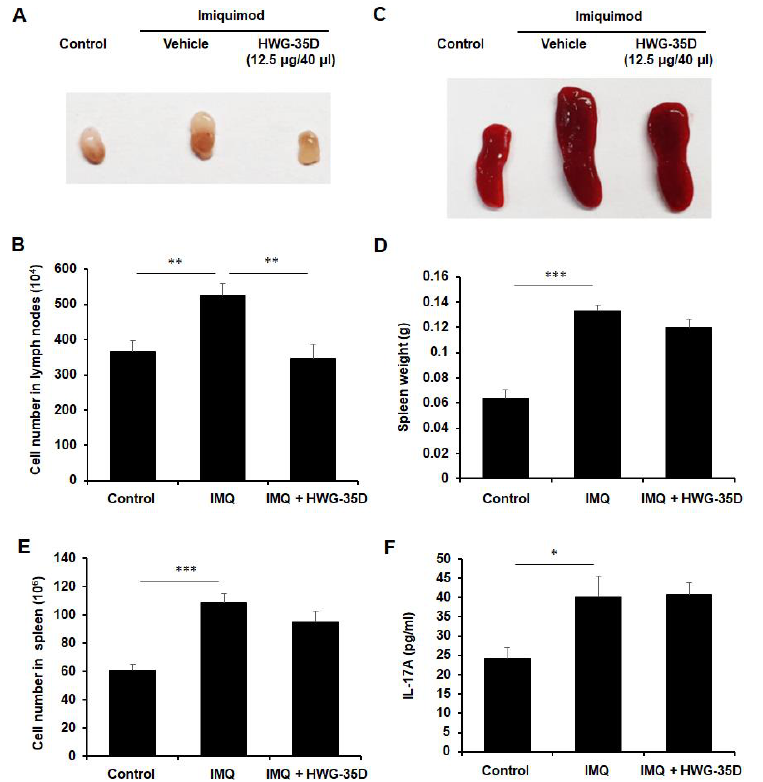
Figure 6. Topical application of HWG-35D with a dosage of 12.5 µg/40 µL surfactant only partially normalizes systemic immune response. ( A ) Gross morphologic examination of inguinal lymph nodes, and ( B ) their total cell numbers were counted in each group. ( C ) Gross morphologic features, ( D ) weights, and ( E ) total cell numbers of spleen were examined. ( F ) Serum IL-17A levels were examined using ELISA. Data are mean ± S.E.M. values ( n = 5). * p < 0.05, ** p < 0.01, *** p < 0.001.